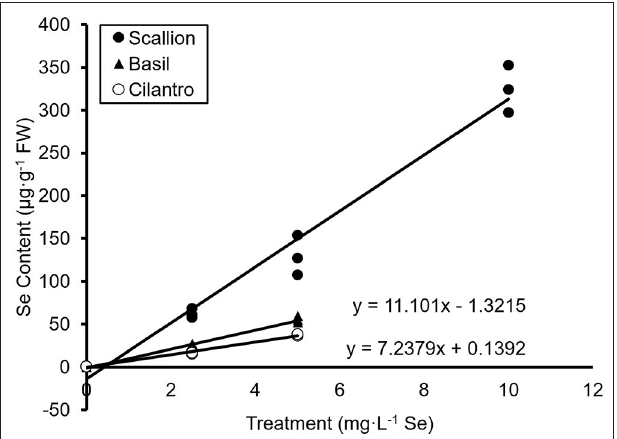
FIGURE 2 | Regression analysis of fresh weight (FW) selenium (Se) content of scallion ( Allium fistulosum L.), basil ( Ocimum basilicum L.), and cilantro ( Coriandrum sativum L.) microgreens treated with various concentrations of Se as sodium selenate ( n = 3).